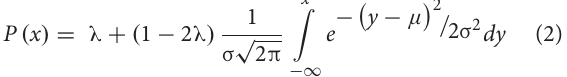
by pressing one of the two available buttons. Between trials, the screen was black for 400